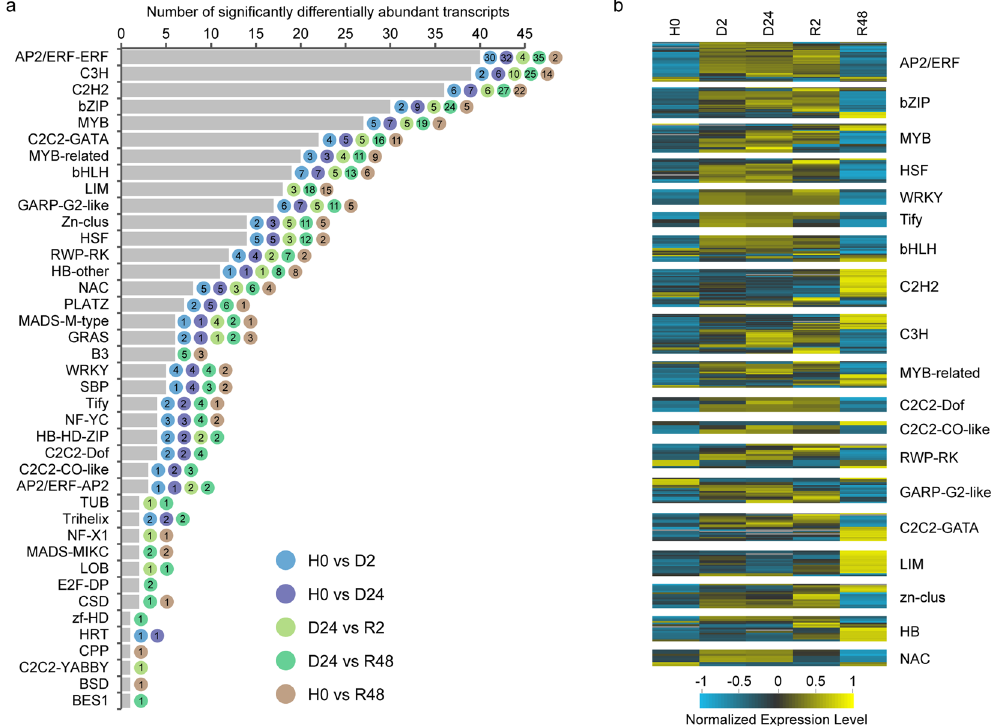
Figure 7. Abundance altered transcription factor (TF)-coding transcripts in Bryum argenteum during dehydration and rehydration. ( a ) A total of 404 TFs belonging to 40 TF family exhibited significantly differential abundance during dehydration and rehydration. The color code showed the differential abundance of transcripts belonging to a certain TF family for that hydration stage in comparison with H0 or D24. ( b ) Heatmaps illustrating the expression profiles of the significantly differentially abundant transcripts of interested TF